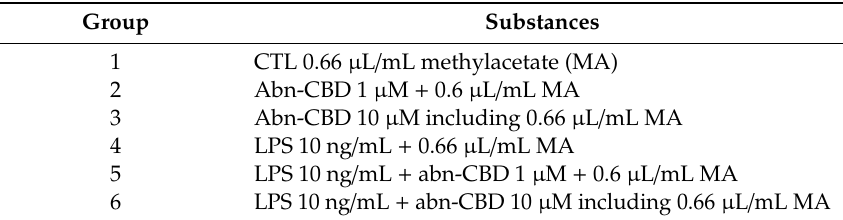
Table 1. Treatment groups for cytokine and nitrite measurement